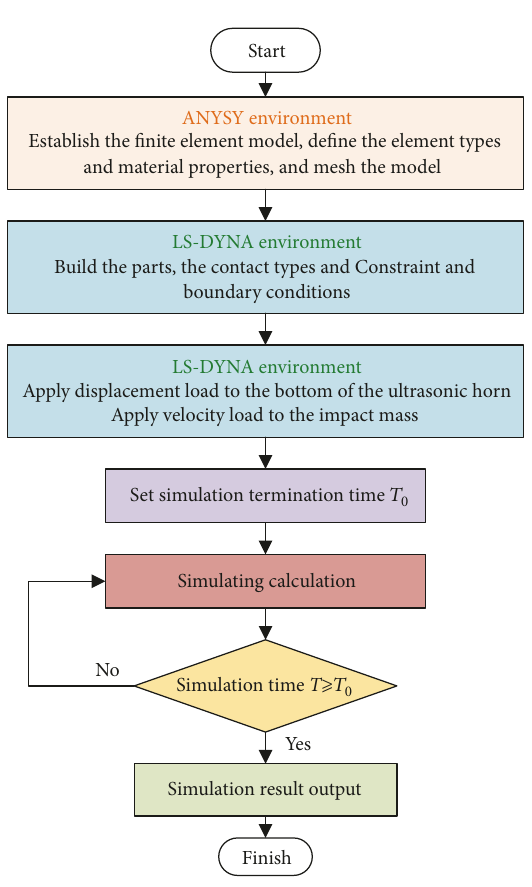
Figure 9: The flowchart of the simulation process using ANSYS and LS-DYNA